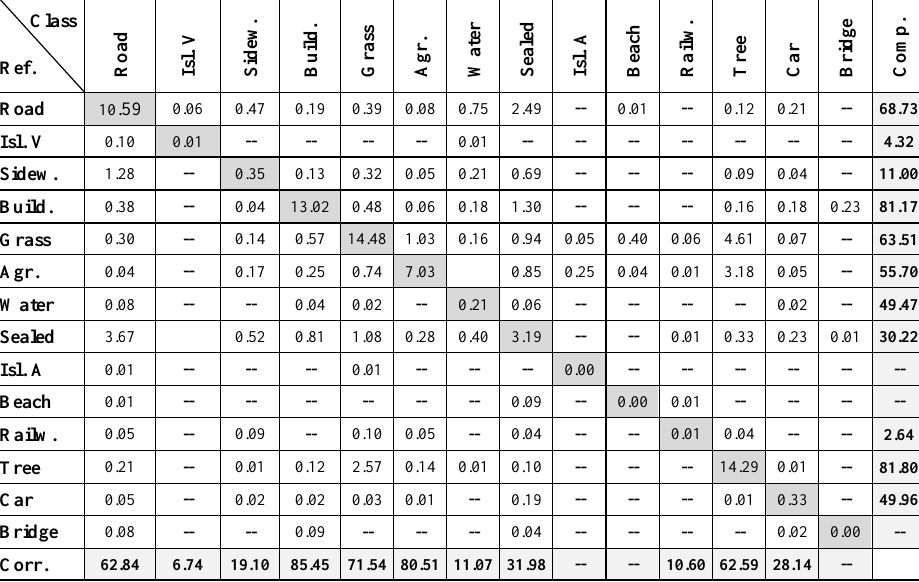
Table 1: Confusion matrix for the experiment using 14 classes and the car confidence feature. All values are given in [%]. Overall accuracy: 63.50%. Abbreviations: Ref.: Reference; Isl. V: traffic island with vegetation ; Sidew.: sidewalk ; Build.: building ; Agr.: agricultural ; Isl. A: traffic island with asphalt ; Railw.: railway ; Comp. / Corr.: Completeness / Correctness.